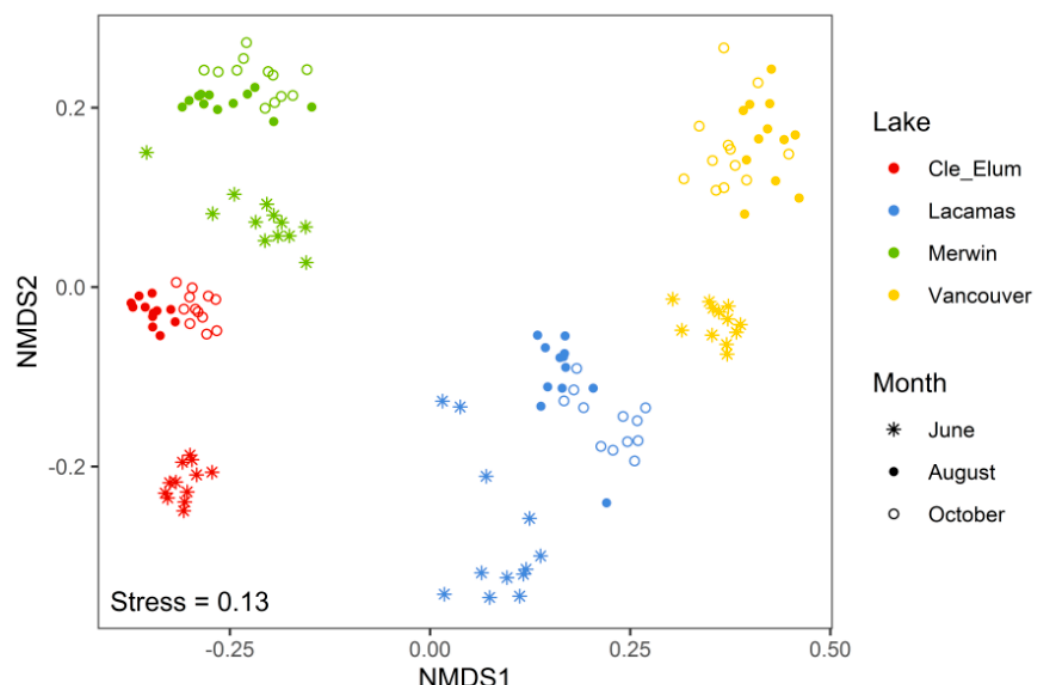
Table 3. Results of nested two-way PERMANOVAs conducted separately in June, August, and October, testing the effects of enhanced grazers and enhanced nutrients, nested within lake, on microplankton assemblage structure.